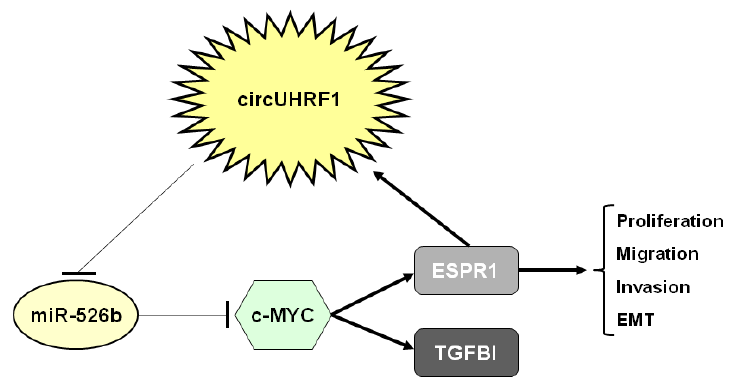
Figure 2. Molecular mechanism of circUHRF1.